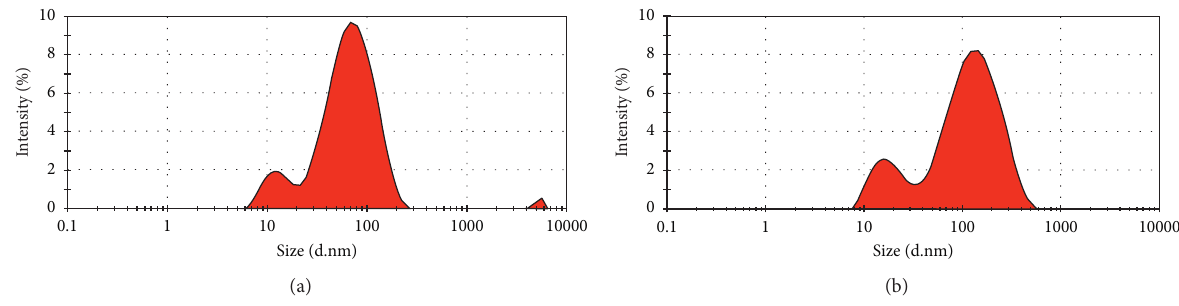
Figure 4: Size distribution for long term of the colloidal Ag-NPs stabilized by PHMB ((a) 2 hours; (b) 180